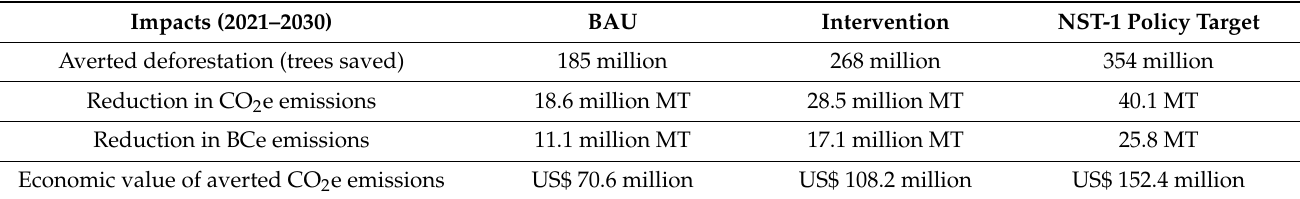
Table 2. Cumulative impacts on the environment and climate of projected LPG adoption for each of the modelled scenarios (2021–2030).